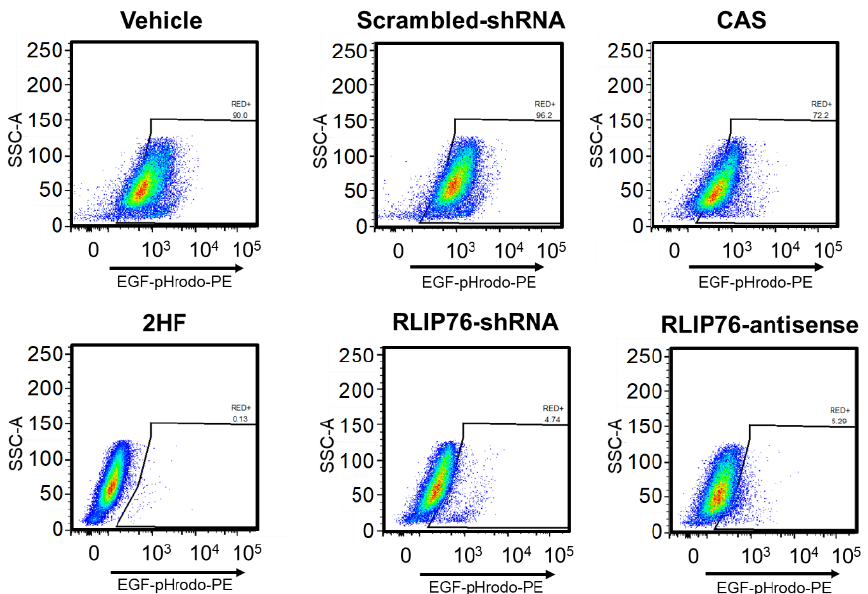
Figure 4. Flow cytometry analysis of EGF-pHrodo endocytosis in control or Rlip depleted B16-F0 cells. Flow cytometry analysis of B16-F0 cells was performed 24 h after Rlip depletion by shRNA, RLIP76- antisense, or treatment with 100 µM 2HF. Cells were stained with EGF-pHrodo. EGF-pHrodo-positive cells as shown on scatter plots were identified and gated based on forward and side scatter properties.